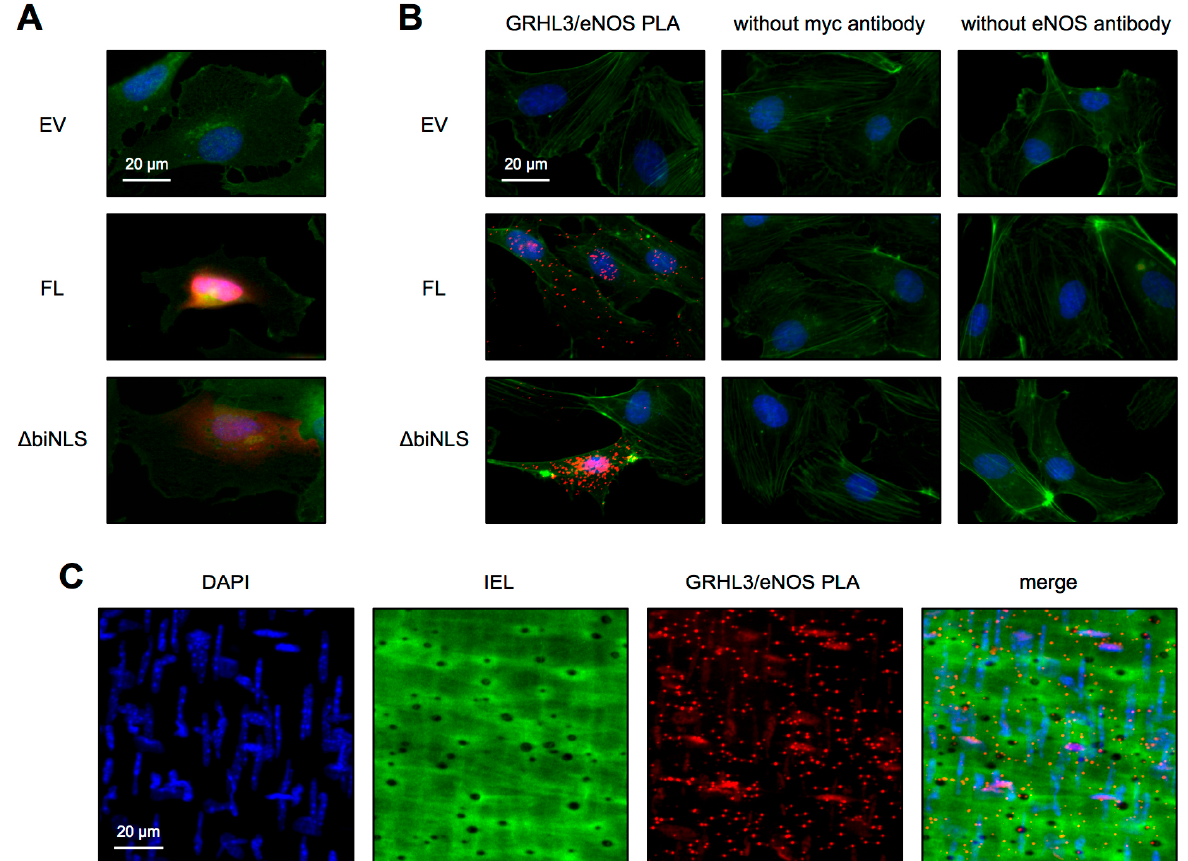
Figure 6. GRHL3 and eNOS interaction ex vivo and in vivo. ( A , B ) EC were transfected with an empty vector, GRHL3 FL or GRHL3 ∆ biNLS plasmids. ( A ) Representative immunostainings. Co-immunostainings with an anti-myc-tag antibody and an eNOS antibody were performed. Myc-tag represents GRHL3 variants (red), eNOS is shown in green, nuclei were stained with DAPI (blue). ( B ) Proximity ligation assay (PLA) was performed with an antibody against the myc-tag and an eNOS antibody (GRHL3/eNOS PLA, left panels). As negative controls, PLAs were performed, omitting either the myc antibody (middle panels) or the eNOS antibody (right panels). Red dots represent eNOS and GRHL3 interactions. The actin cytoskeleton was stained with Phalloidin (green) and nuclei with DAPI (blue). ( C ) Proximity ligation assay (PLA) in the mesenteric artery using GRHL3 and eNOS antibodies. Nuclei were counterstained with DAPI. Horizontally-oriented nuclei are from endothelial cells, and vertically oriented nuclei are from smooth muscle cells. Shown are nuclear stains with DAPI (blue). The autofluorescence of the internal elastic lamina (IEL) is shown in green. Black holes in the IEL represent myoendothelial projections (MEP). Red dots represent eNOS and GRHL3 interactions. Merge is the overlay of all